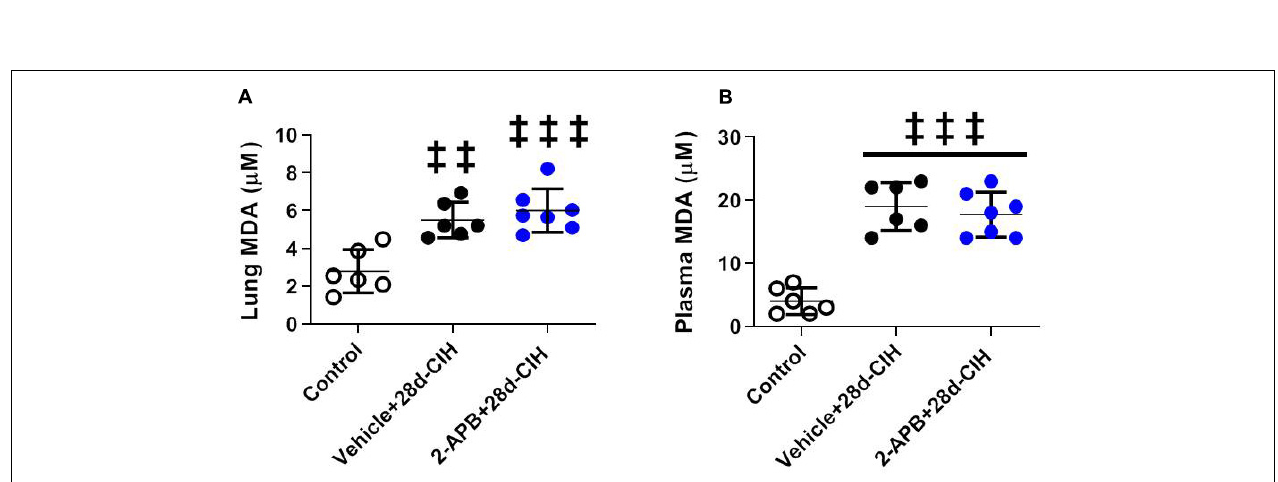
FIGURE 4 | Effect of 2-APB on pulmonary and systemic MDA concentration (TBARS) following chronic intermittent hypoxia. (A) MDA lung concentration (ANOVA, P = 0.0002). (B) Systemic plasma concentration (ANOVA, P < 0.0001) in control (empty circles, n = 6), exposed to Vehicle + 28d-CIH (black circles, n = 6), and 2-APB + 28d-CIH rats (blue circles, n = 7). Mean ± SD. ‡‡ P < 0.01 vs. Control, ‡‡‡ P < 0.001 vs. Control. One way ANOVA-Newman followed by Keuls tests.